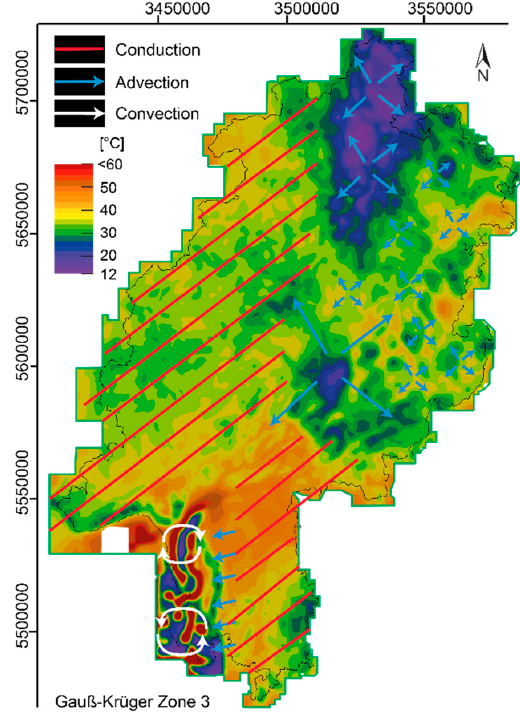
Figure 12. The Federal State of Hesse is subdivided into areas of different characteristic types of heat transport mechanisms; conduction in red, advection in blue and convection in white.